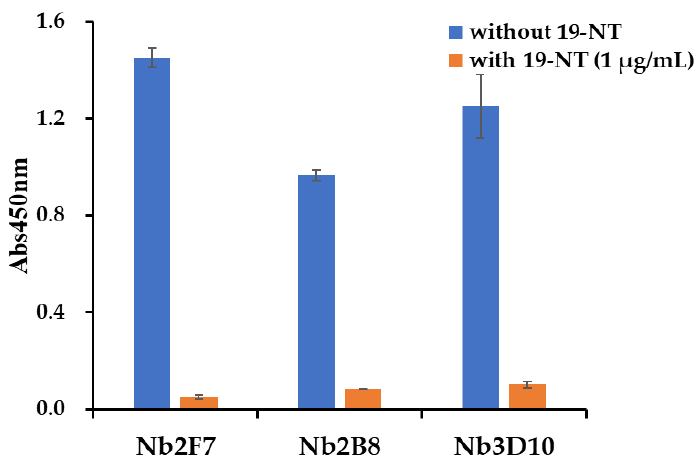
Figure 2. Positive clones identified by indirect competitive enzyme-linked immunosorbent assay (ic-ELISA) analysis of the expression supernatant.